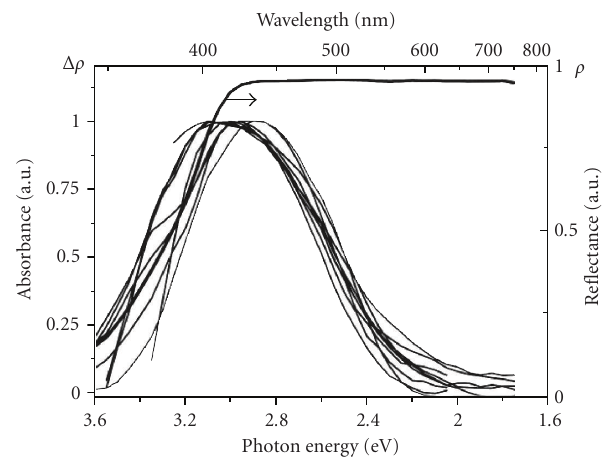
Figure 10: Absorption spectra of various anion-doped TiO 2 spec- imens before averaging (see text) and the di ff use reflectance spec- trum (DRS) of Degussa P25 TiO 2